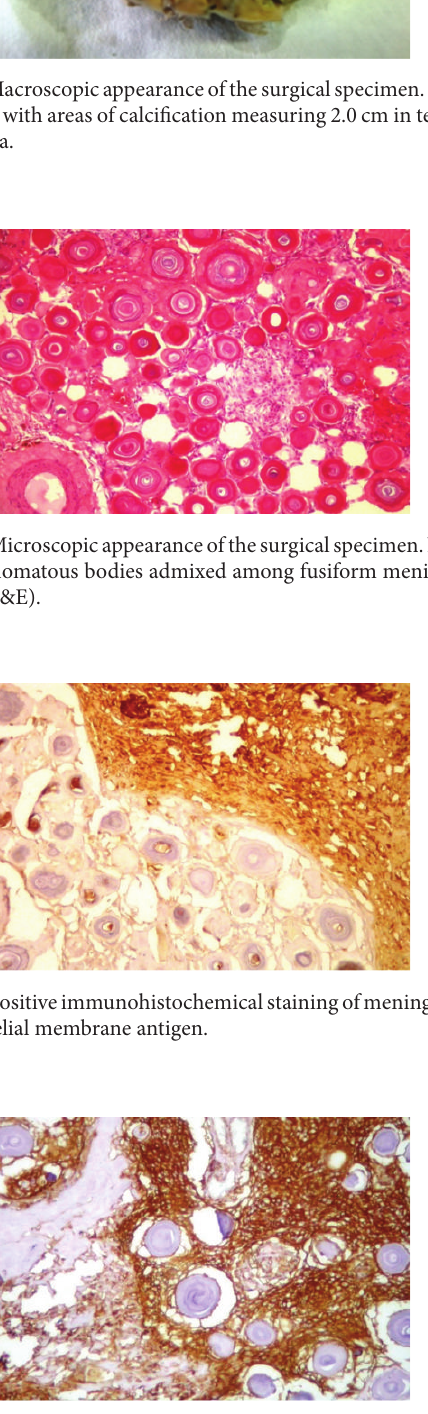
Figure 4: Immunohistochemical staining positive for vimentin in meningothelial